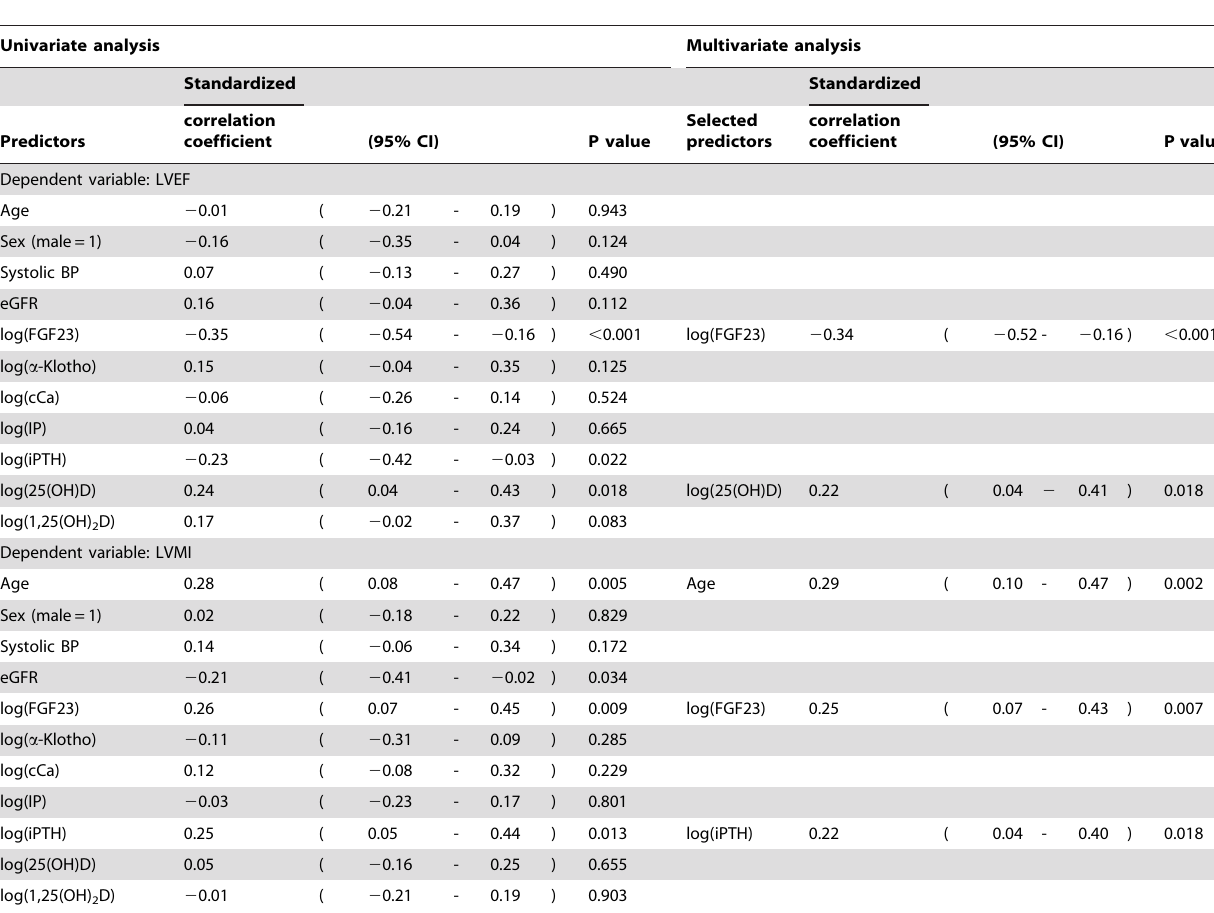
Table 6. Univariate and multivariate analysis for the association with ejection fraction and mass index of the left ventriculum.